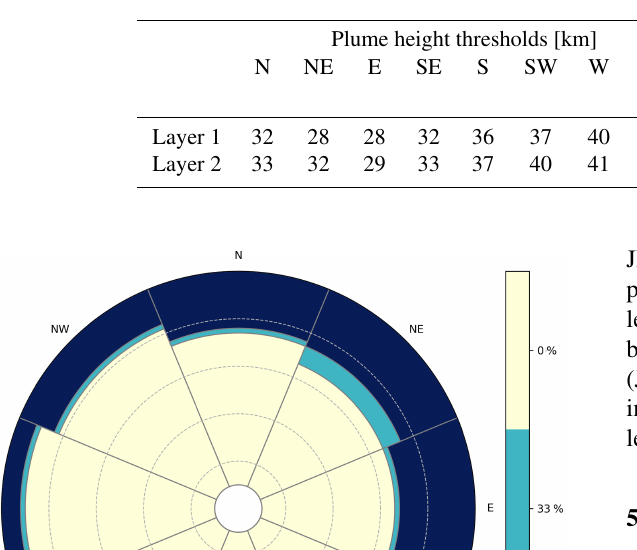
Table 6. Parametric trigger for Mt Fuji. The risk transferred by each layer is expressed as percentage over the total risk of Mt Fuji. The layer payment is expressed as fraction of the maximum payment (JPY300 billion).